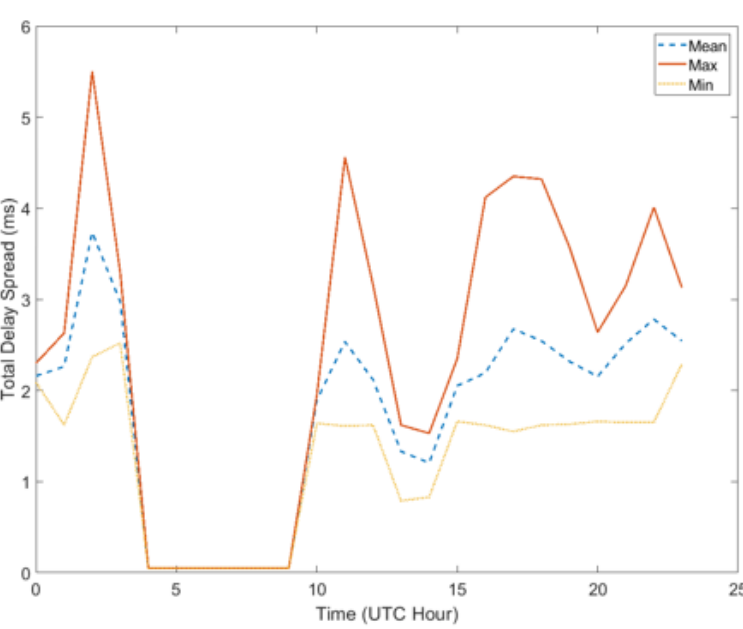
Figure 10. NVIS with groundwave Total Delay Spread vs Time.